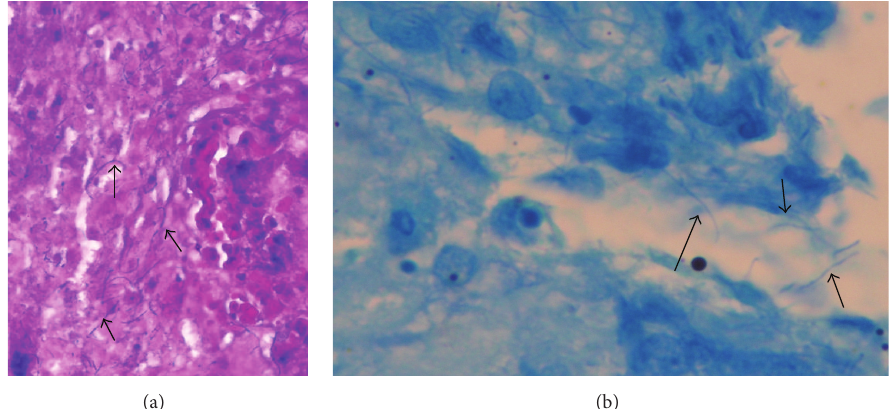
Figure 3: (a) Gram stain ( × 40). Arrows point toward Gram-positive filamentous microorganism. (b) Ziehl-Neelsen stain ( × 100). Arrows point toward partially acid-fast beaded branching filaments.